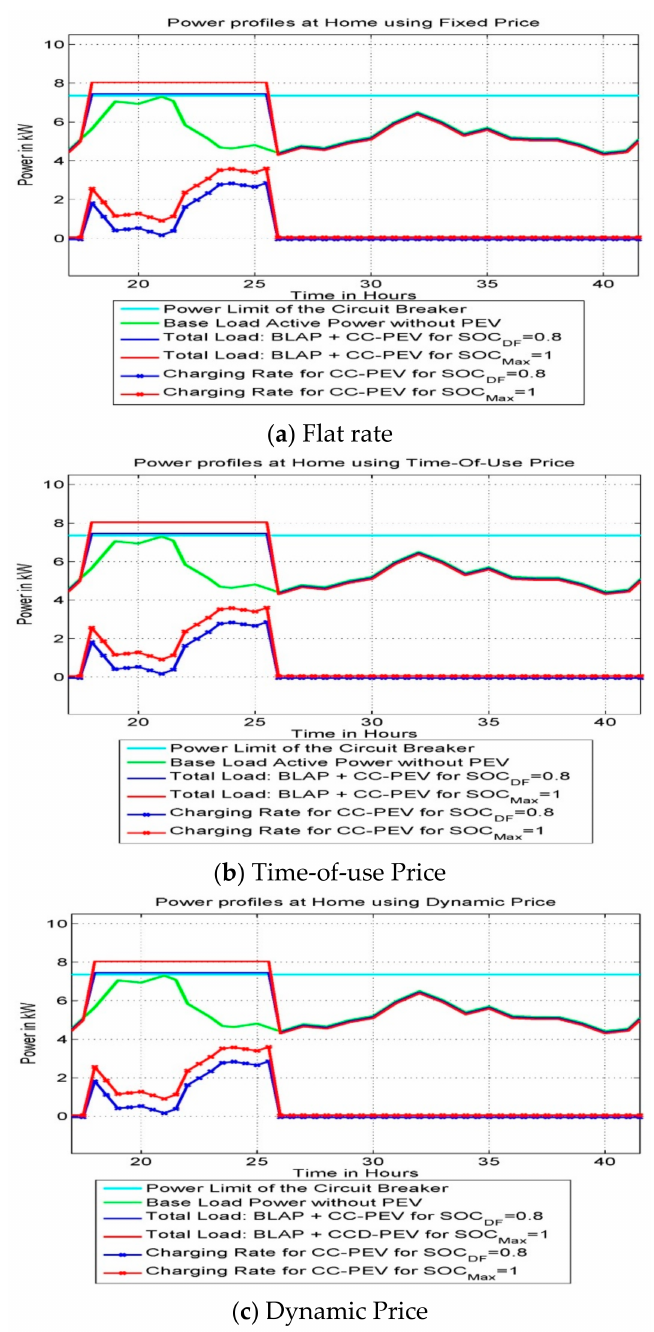
Figure 7. Power profiles for SOC Max = 1 and SOC D = 0.8, for ( a ) Flate rate, ( b ) TOU, ( c ) Dy- namic